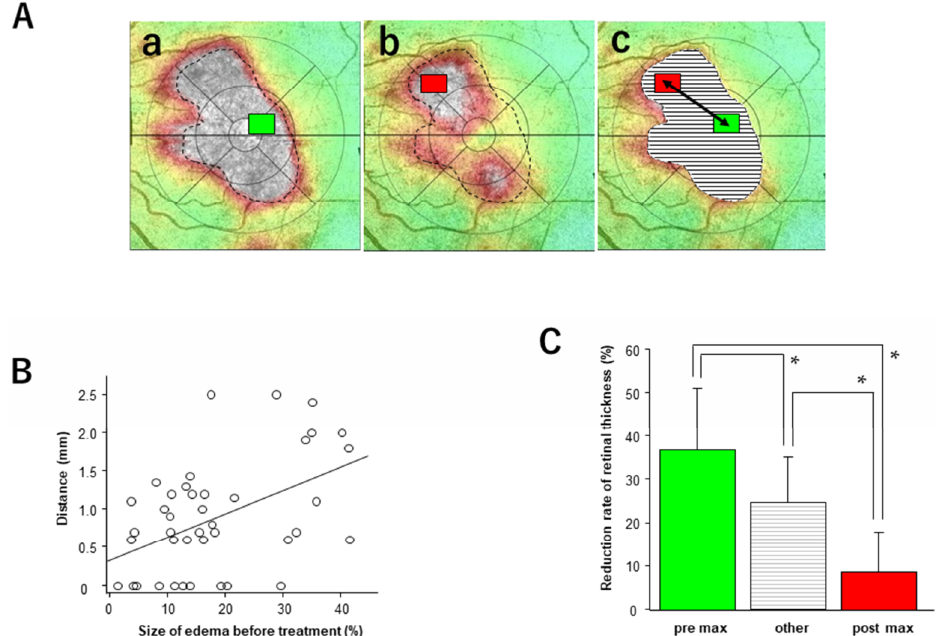
Figure 3. Analysis of the areas with maximum retinal thickness before and after injection. ( A ) OCT map of a representative case ( a – c ). The broken line indicates an outline of the severely edematous area. Green and red rectangles indicate the maximum area before ( a ) and 1 month after injection ( b ). The distance between the center of the green and red rectangles (arrow) is measured ( c ). The other areas are indicated by horizontal borders. ( B ) Linear correlation between the distance of the maximum thickness area and the size of the severe edema before injection. Significant correlations were observed ( p = 0.002, R 2 = 0.20). ( C ) Comparison of the reduction rate of retinal thickness among the areas with maximum thickness before and after injection and the other areas. The color and texture link is shown in ( A ). Data represent mean ± standard deviation (SD). * p < 0.05.